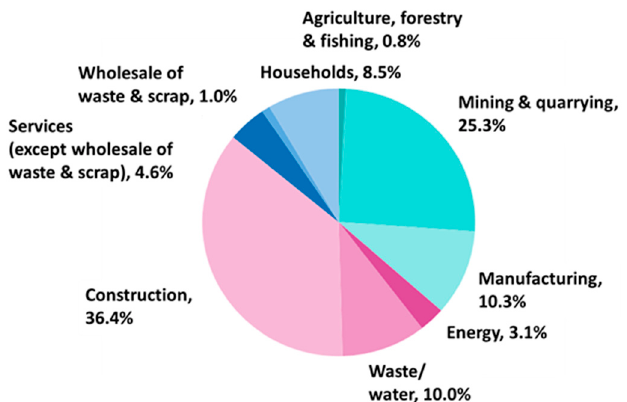
Figure 1. Waste generation by economic activities and households, EU-28, 2016.